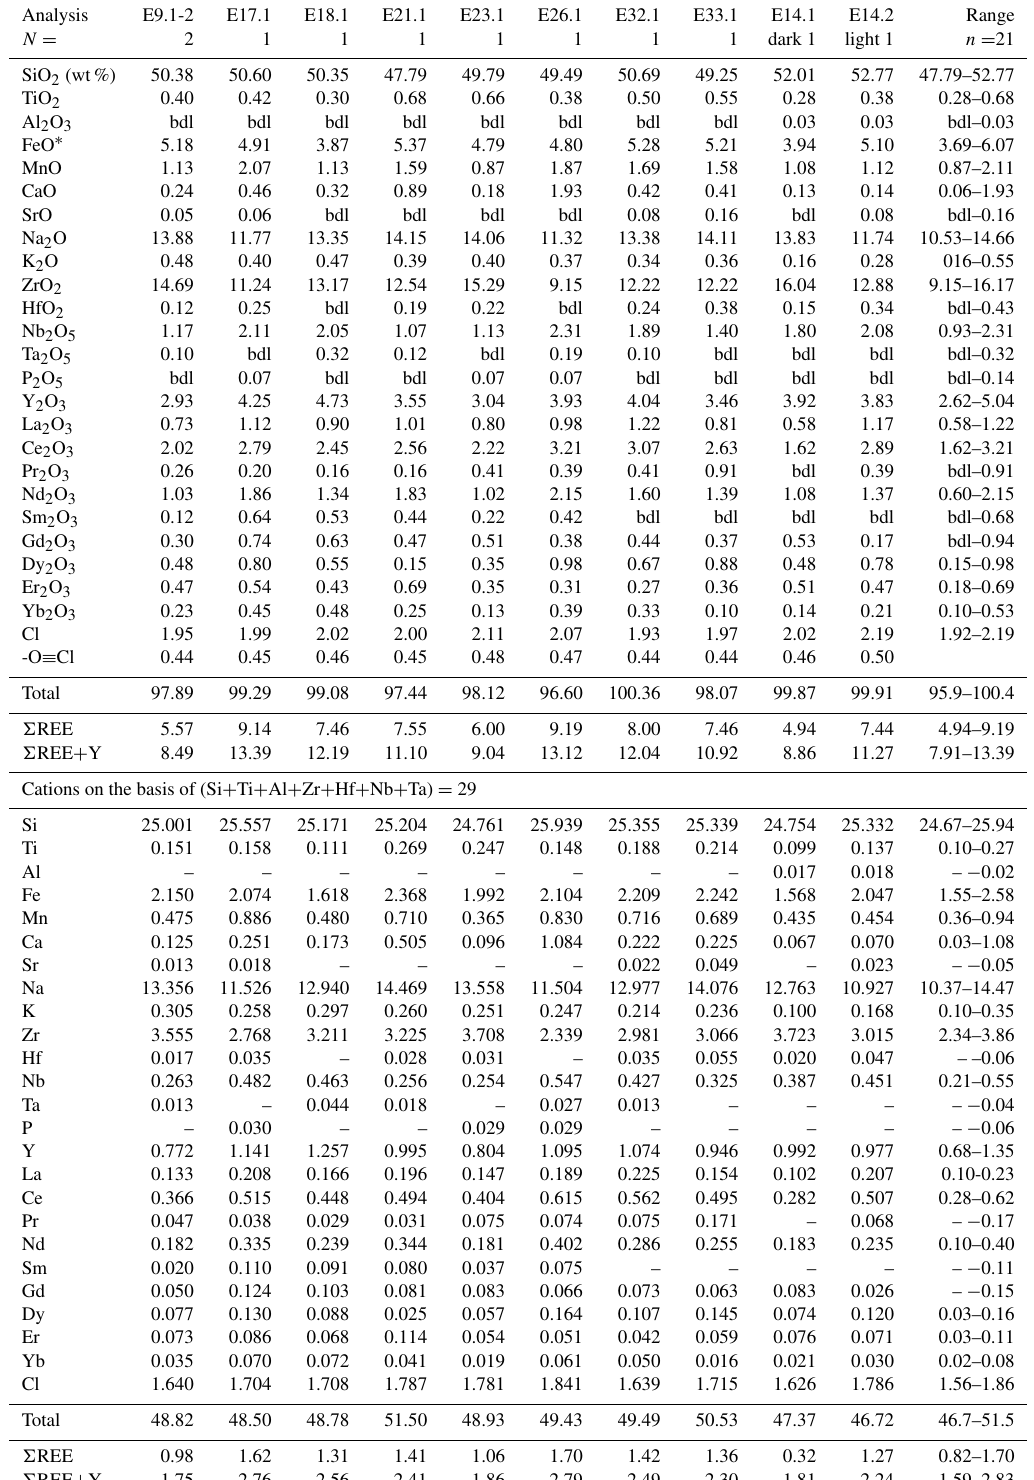
Table 13. Representative compositions of probable eudialyte-group minerals in Ailsa Craig granite DV24828.